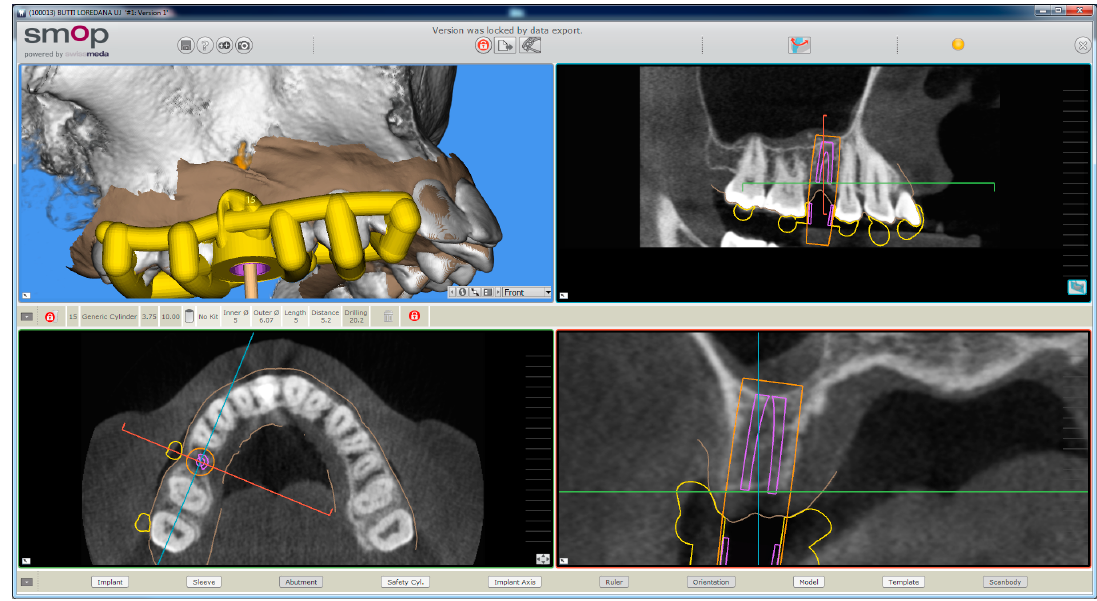
Figure 3. The implant is planned with the aid of a guided surgery software (SMOP ® , Swissmeda, Baar, Switzerland). A 3.75 mm × 10 mm implant (BT Safe Bone Level ® , BTK, Dueville, Italy)